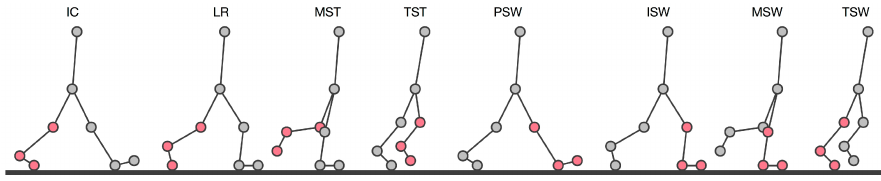
Figure 4. Eight phases of the human gait cycle.